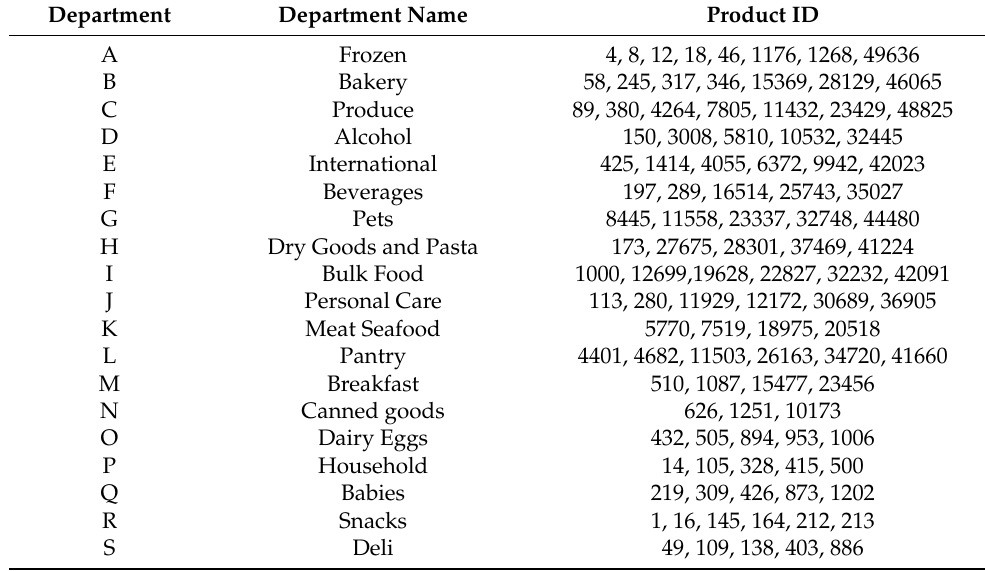
Table 3. Examples of departments.